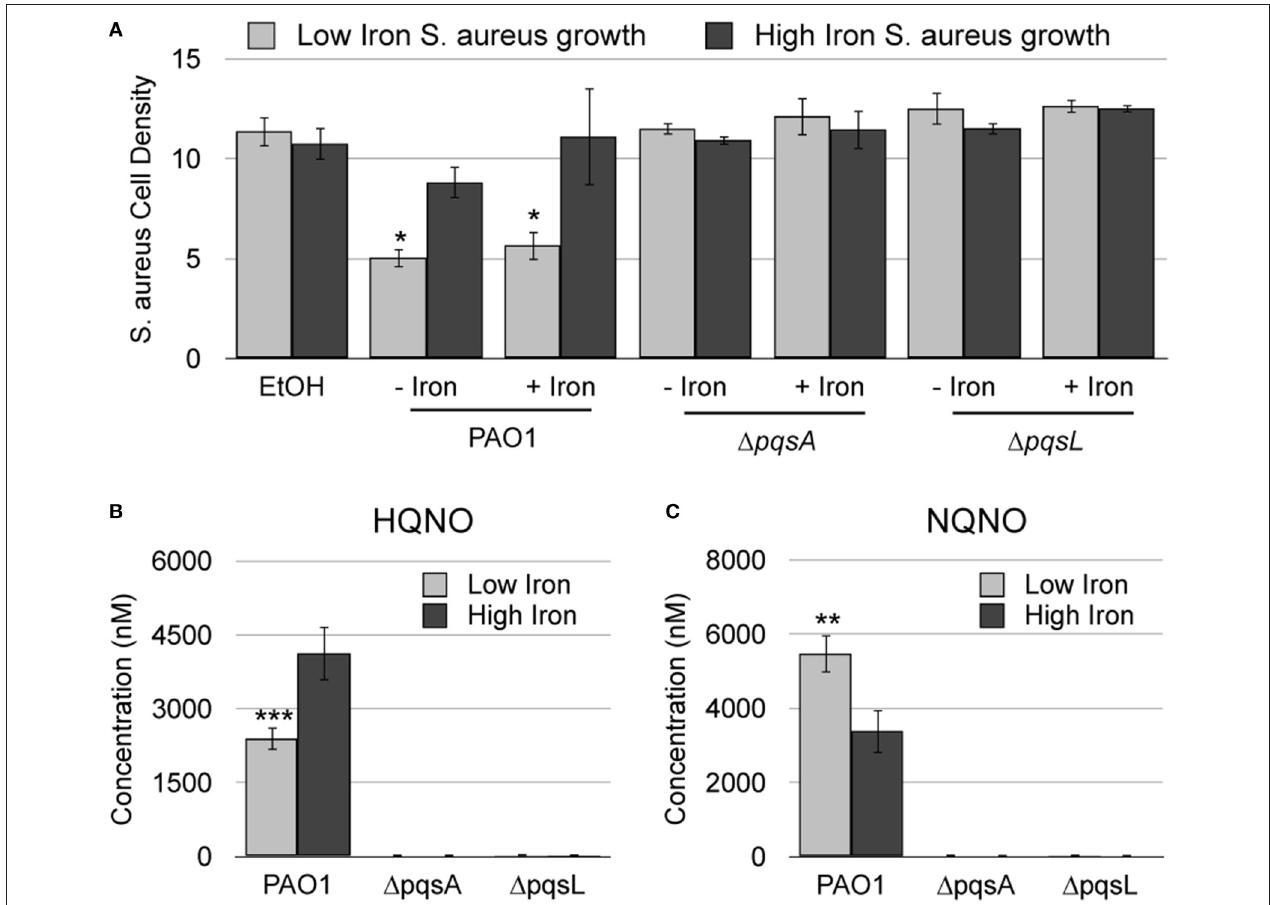
FIGURE 2 | AQNO-dependent antimicrobial activity against S. aureus is dependent upon iron depletion. (A) S. aureus was grown overnight in DTSB supplemented with or without 100 µ M FeCl 3 and with the indicated P. aeruginosa AQ extracts, prepared as described in the Section Materials and Methods. (B) Culture supernatant extracts from the indicated P. aeruginosa strains were prepared and analyzed by LC-MS/MS as described in the Section Materials and Methods. Error bars indicate standard deviation of three (A) or five (B) biological replicates. Asterisks (*) indicate the following p -values as determined by two-tailed Student’s t -test: * p < 0.05, ** p < 0.005, *** p < 0.0005 when comparing low iron to high